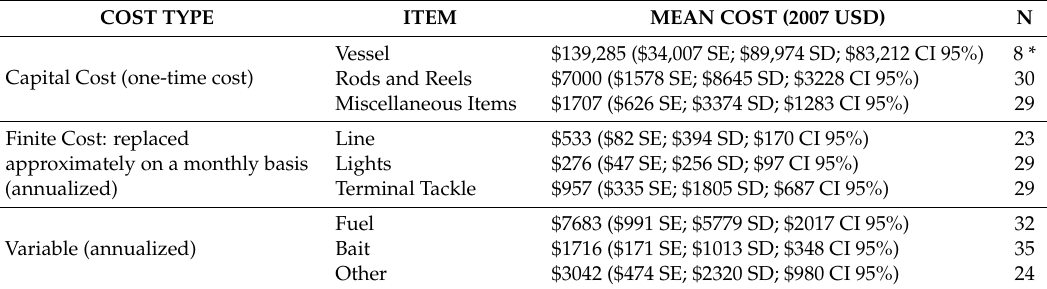
Table 1. Mean expenditures associated with the Southeast Florida recreational swordfish